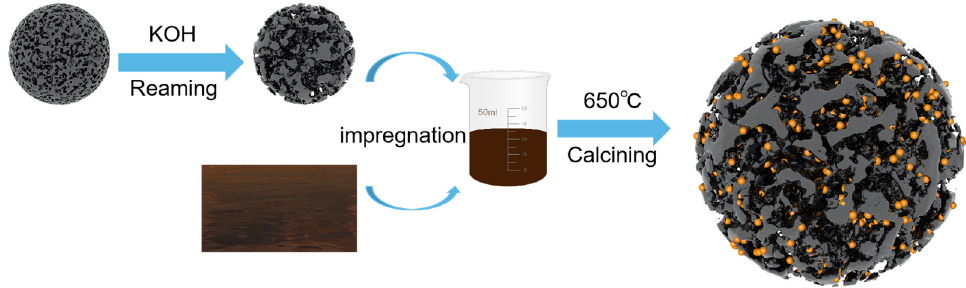
Figure 7. PCW preparation flow chart.